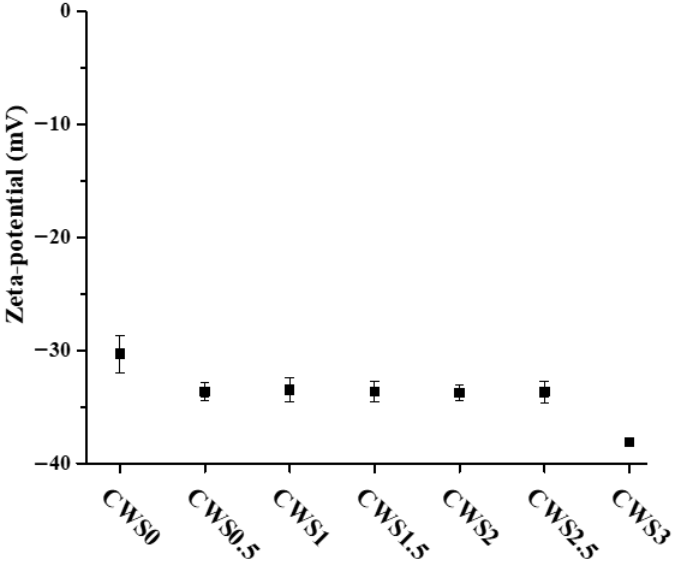
Figure 4. The zeta-potential values of 0.001 wt% aqueous dispersion of the initial SrTiO 3 (CWS0) and CWSX samples (pH = ~6.50).